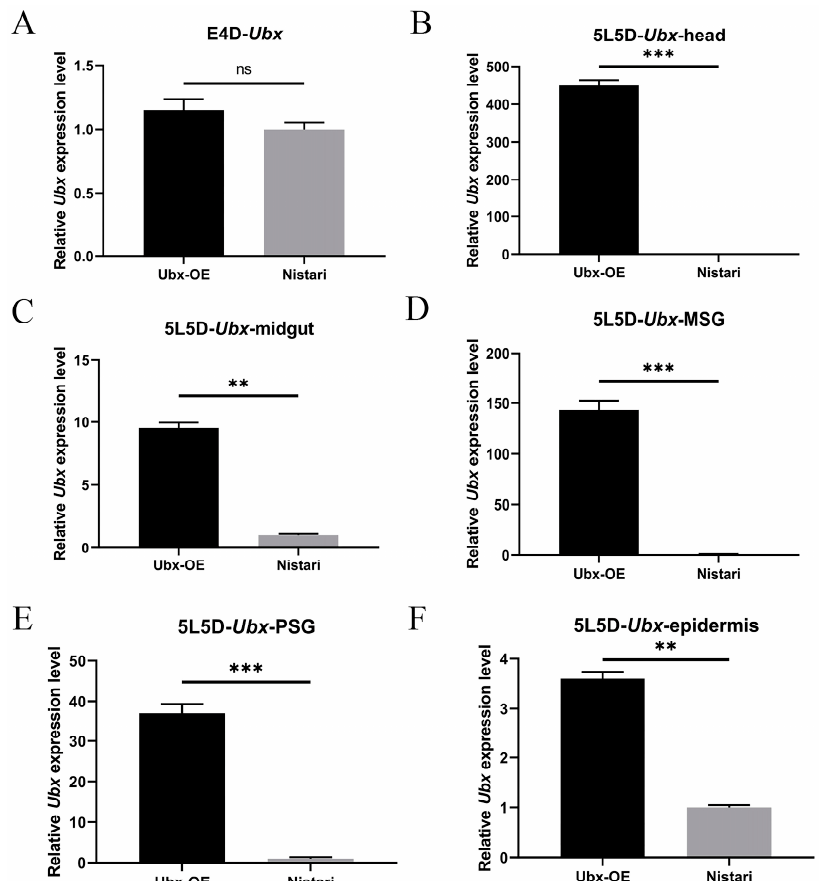
Figure 2. The relative expression level of Ubx in different tissues of UbxOE and Nistari silkworms. ( A ) The expression level of Ubx in eggs of Ubx OE and Nistari on the fourth day of embryonic stage (E4D). ( B ) The difference in Ubx expression level in head on the fifth day of fifth instar (5L5D). ( C ) The difference in Ubx expression level in midgut on 5L5D. ( D ) The difference in Ubx expression level in middle silk gland on 5L5D. ( E ) The difference in Ubx expression level in posterior silk gland on 5L5D. ( F ) The difference in Ubx expression level in epidermis on 5L5D. Ubx-OE, the transgenic strain with Ultrabithorax overexpressed, namely Ubx OE . Nistari, the control of Ubx OE . Error bars indicate the standard error of the mean ( n = 3). Significant differences were assessed using Student’s t -test (ns p > 0.05, ** p < 0.01, and *** p < 0.001).